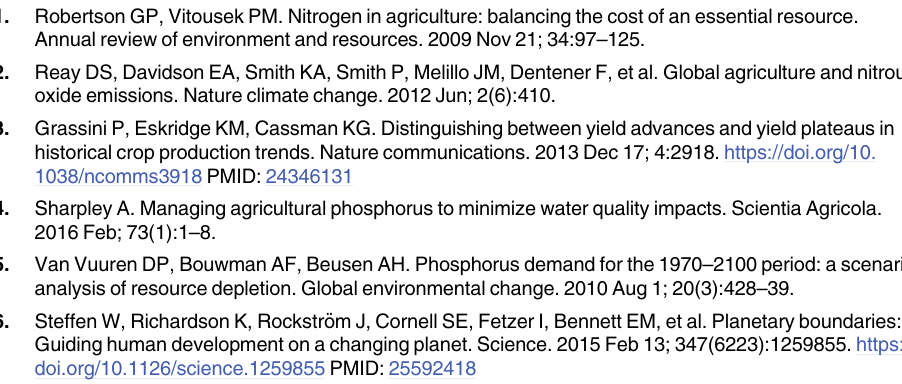
S1 Table. Sample